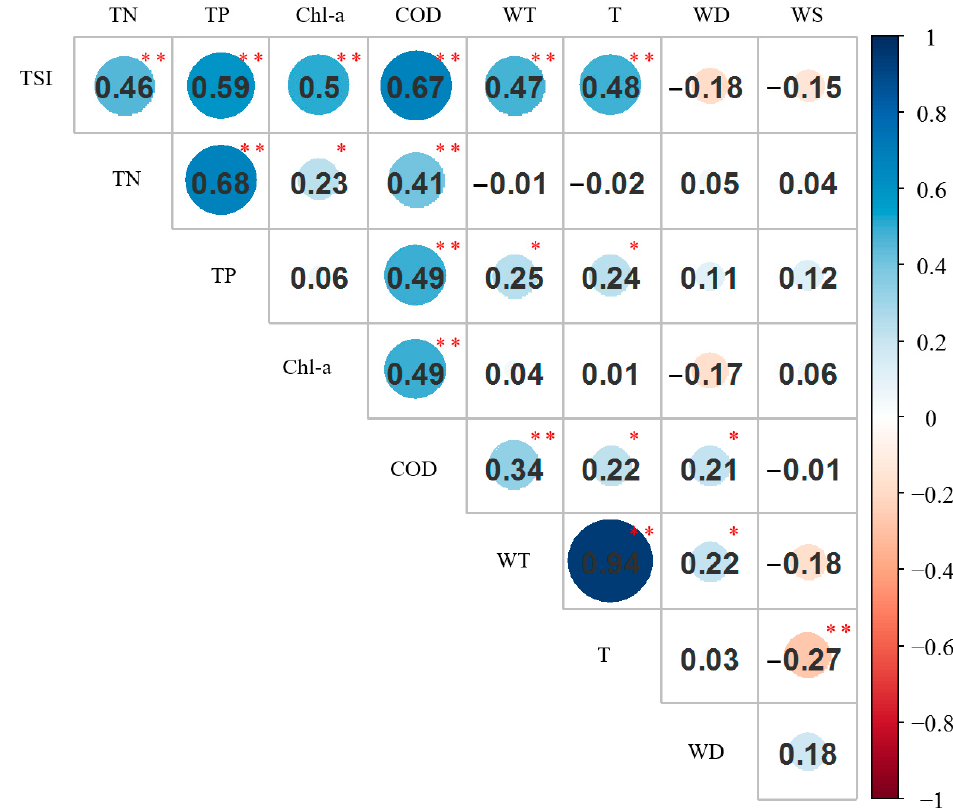
Figure 4. Correlation between TSI, trophic indicators, and environmental factors. (** marks signif- icant correlation at the 0.01 level (double-tailed), * marks significant correlation at the 0.05 level (dou- ble-tailed).